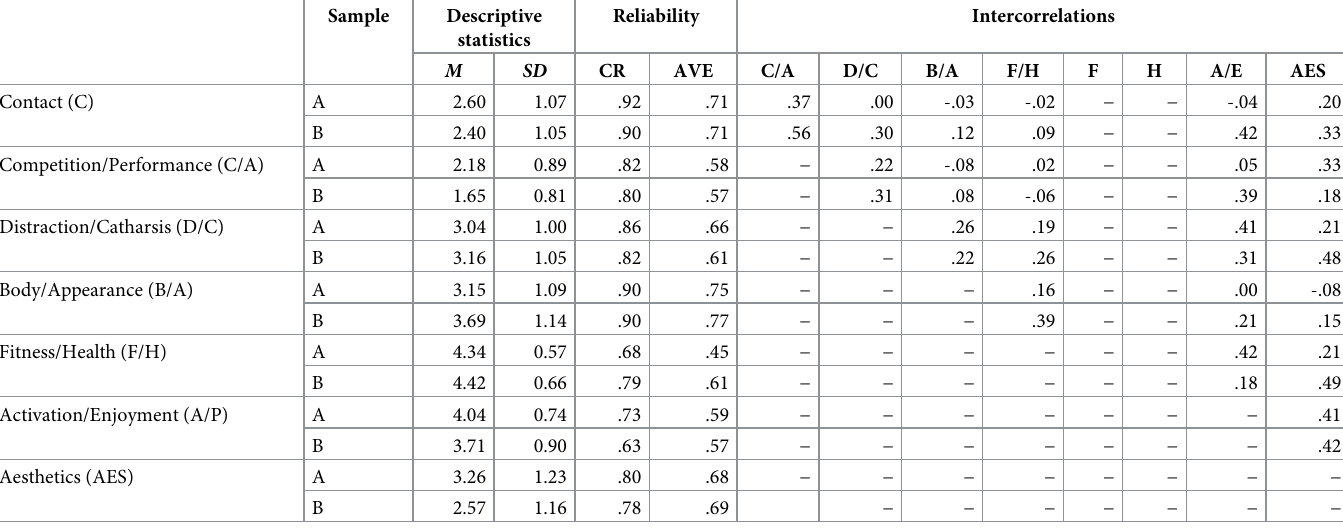
Table 4. Descriptive statistics, reliability and intercorrelations of the original